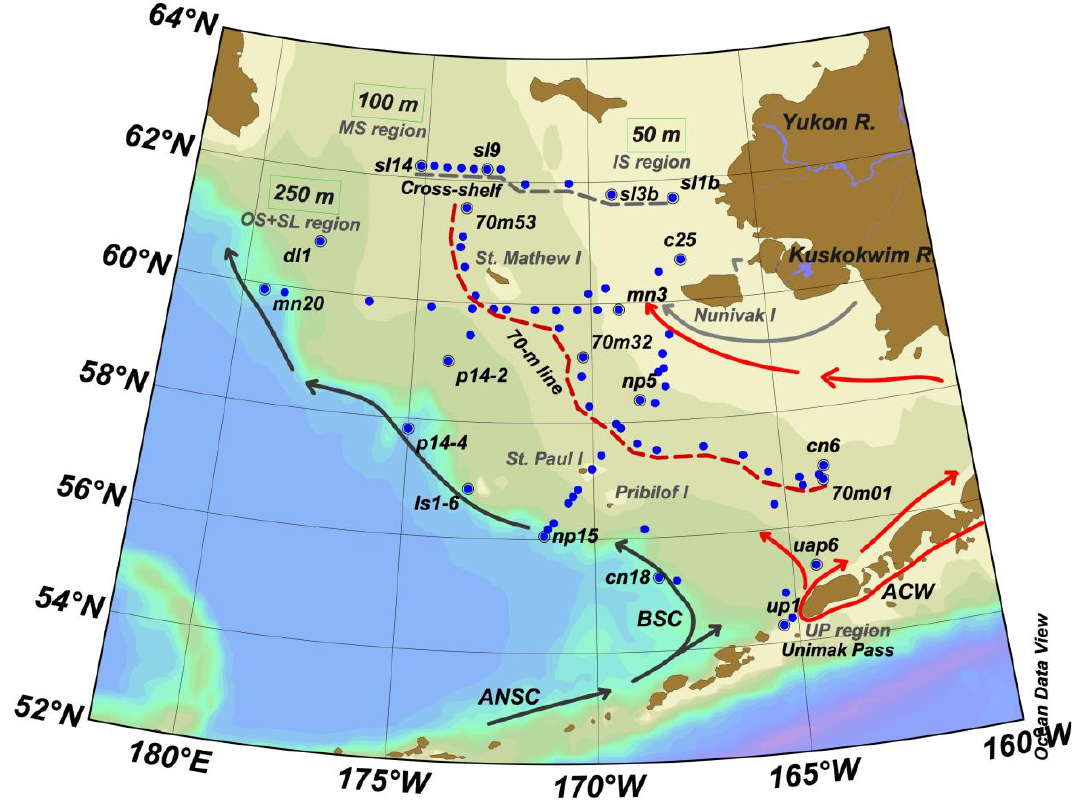
Figure 1. Map of study area showing the station locations (blue circles) sampled during a cruise in July 2008. Depth contours (50, 100 and 250m) demarcate the boundaries of the inner, middle and outer shelves. Cross-shelf (SL) transect and north–south 70m line are shown and discussed in text. General circulation patterns showing Alaska Coastal Water (ACW), the Aleutian North Slope Current (ANSC), and the Bering Slope Current (BSC). The optical properties of the various regions sampled are also described in Tables 1 and